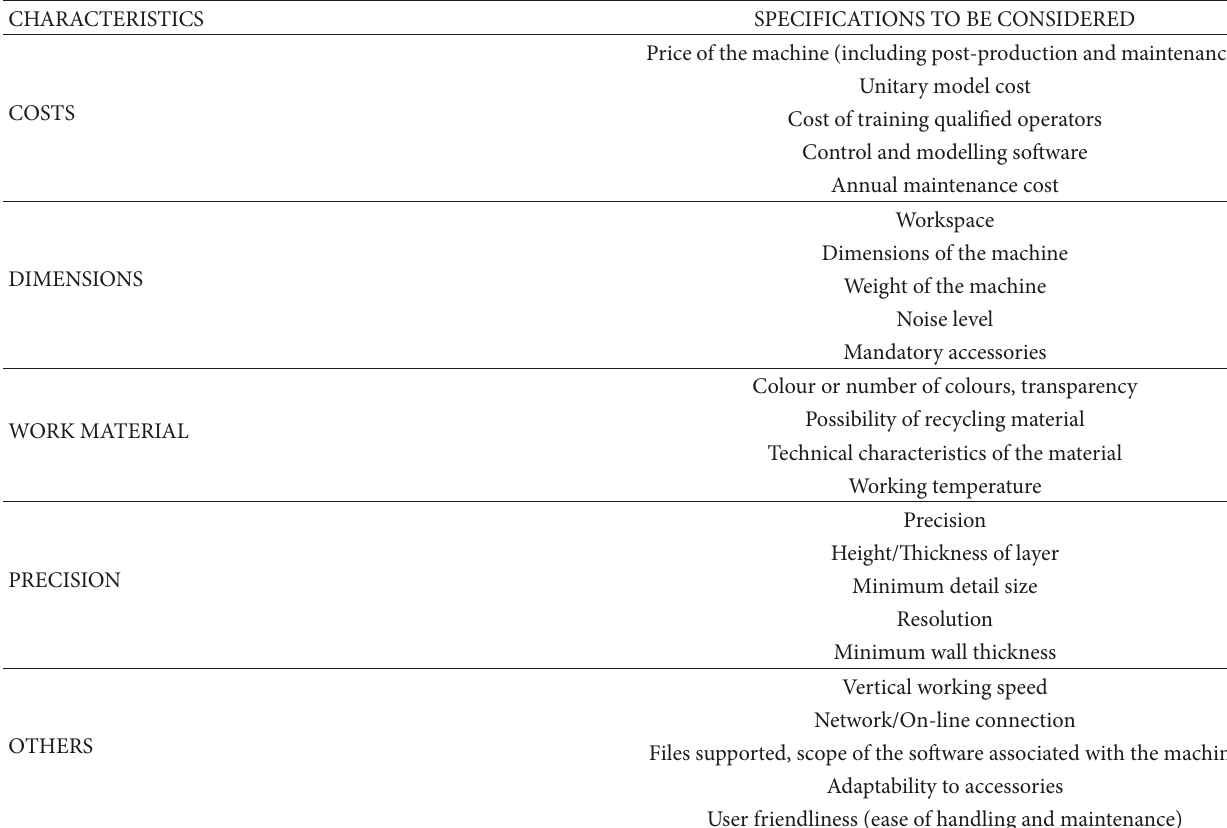
Table 12: Decision variables when choosing a prototyping